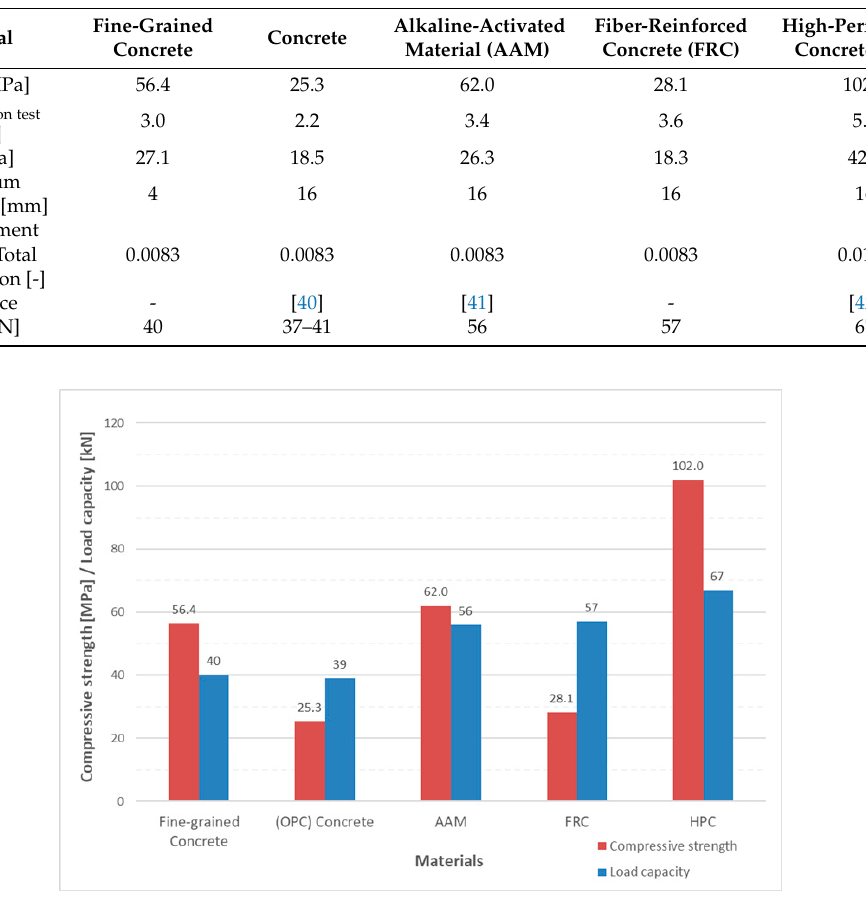
Figure 4. Comparison of load capacity of reinforced concrete beams and compressive